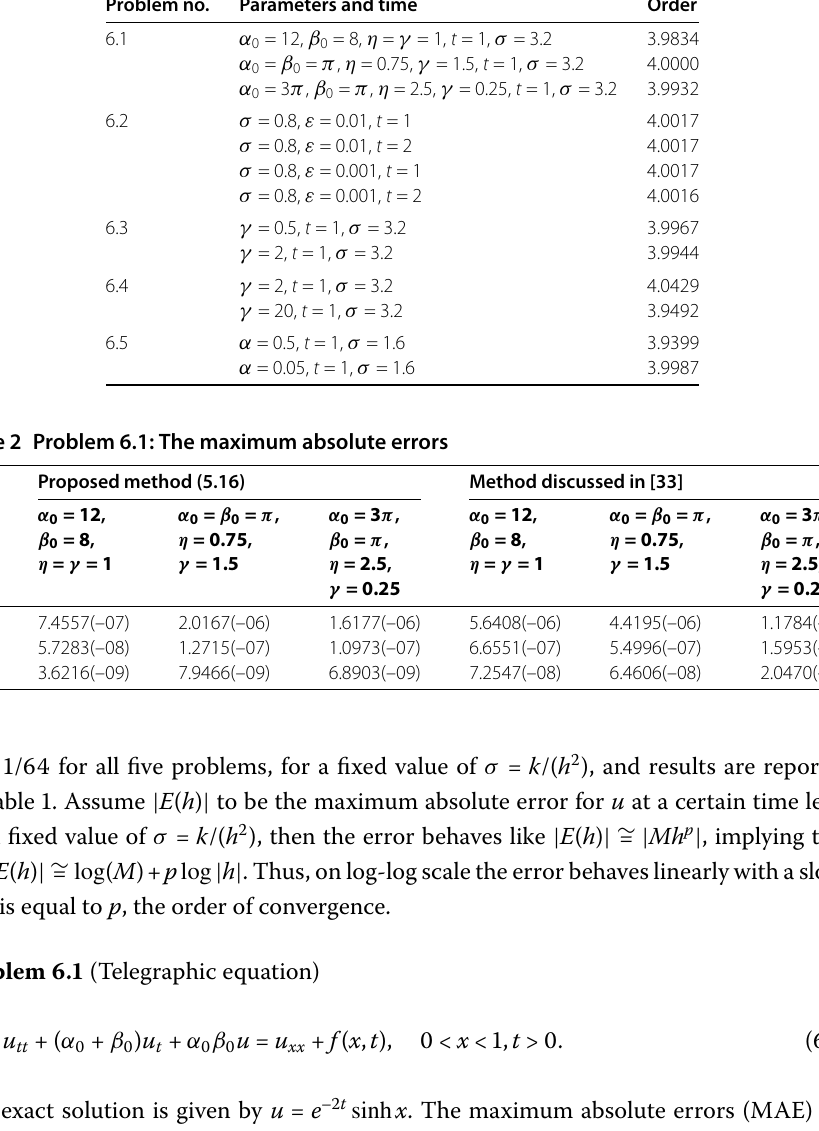
Table 1 Order of convergence Problem no. Parameters and time